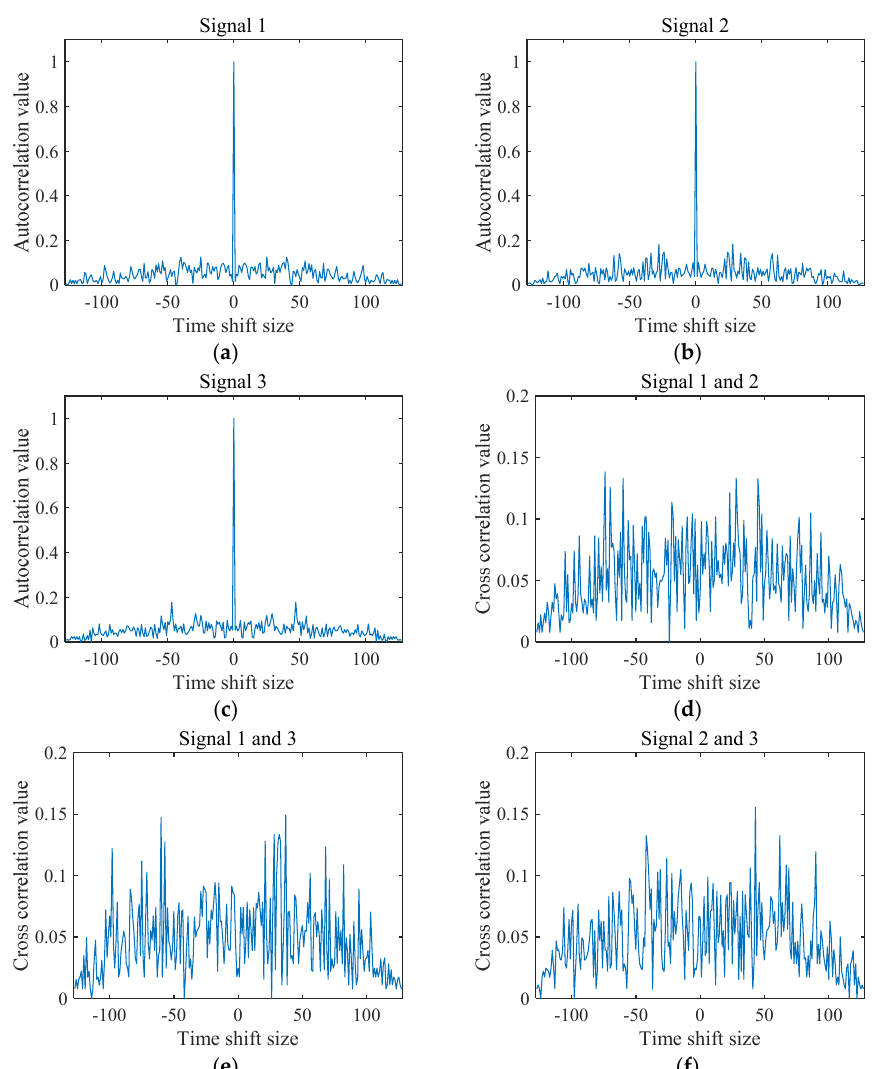
Figure 6. Average autocorrelation and cross-correlation values obtained by IIMO under L = 3, N = 128 on ( a ) Autocorrelation of signal 1, ( b ) Autocorrelation of signal 2, ( c ) Autocorrelation of signal 3, ( d ) Cross-correlation between signal 1 and 2, ( e ) Cross-correlation between signal 1 and 3, ( f ) Cross-correlation between signal 2 and 3.